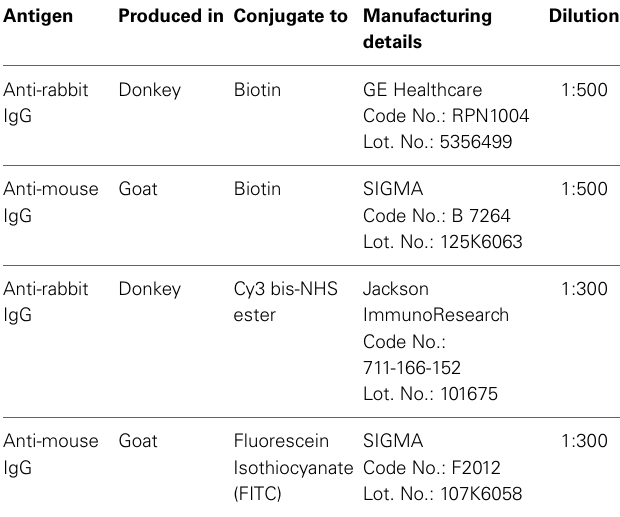
Table 2 | Secondary antibodies used.